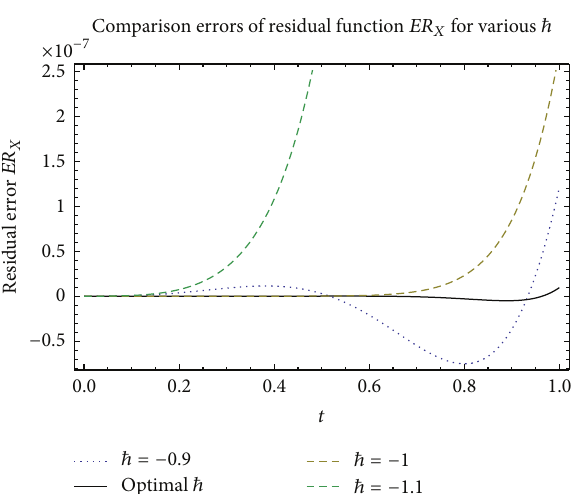
Figure 4: The errors of residual equation (41) using the sixth-order approximate solution for various ℏ and 𝑇 ∈ (0,1)